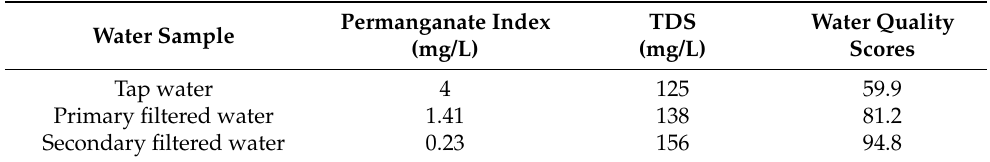
Table 3. Water quality measurement results for tap water, primary filtered water, and secondary filtered water.